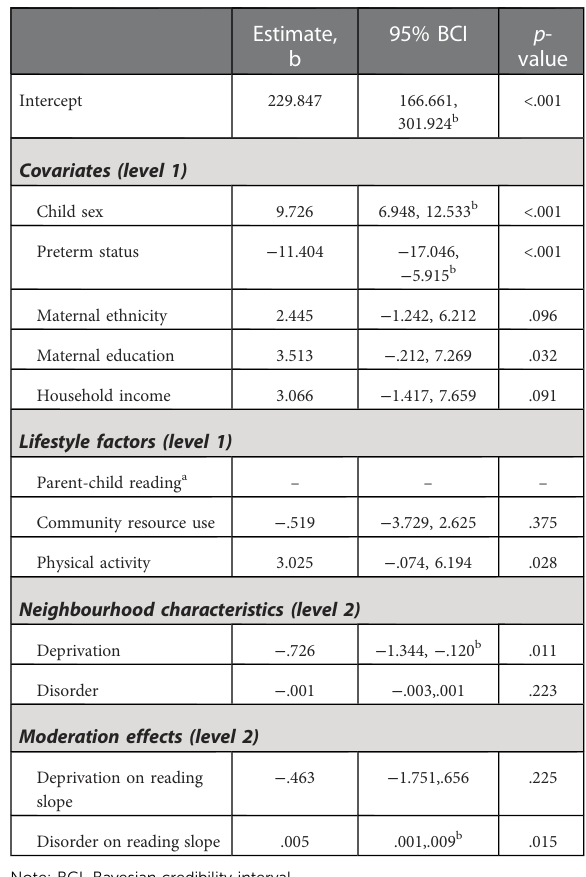
TABLE 3 Final multilevel model of effects on child development at 5 years of age.